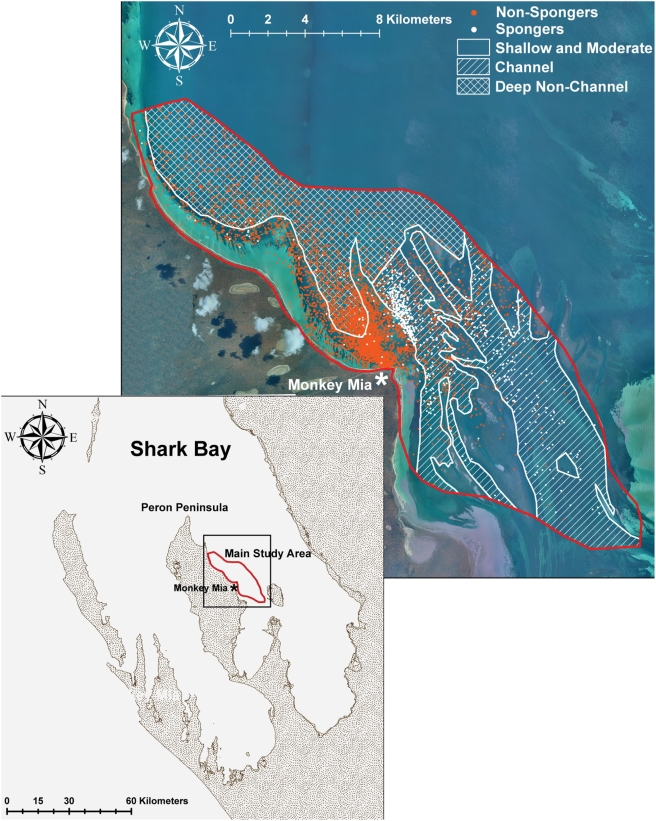
Habitat use of 132 adult female bottlenose dolphins in Shark Bay in 286 km2 study area.Image shows sightings of spongers (white circles, N = 16 spongers, 900 sightings, 52.9±12.6 per sponger) with non-spongers (red circles, N = 116 non-spongers, 9,742 sightings, 84.7±11.3 per female) in our main study area using only one sighting per day per female. In both maps, spongers are placed on top of the other females. Three zones are represented: channels (hatched lines), deep water (cross-hatched) and shallow moderate depth (open). Spongers were sighted 84.1±2.8% of the time in channels. Non-spongers were sighted 17.0±2.2% of the time in channels. If the primary area (>50% of sightings) is used to define adult female density by zone, then 32 females use channels as their primary area (female density = 0.34 females per km2), including all spongers and 16 non-spongers; 48 females use deep water as their primary area (0.60 females per km2) and 44 females use shallow-moderate depths as their primary area (0.40 females per km2). Seven females could not be assigned to a primary area. The map shows where spongers were sighted, but sponge foraging only occurred in channel habitats and, on rare occasion, in the deep (>7 m) northwest portion of the study area.